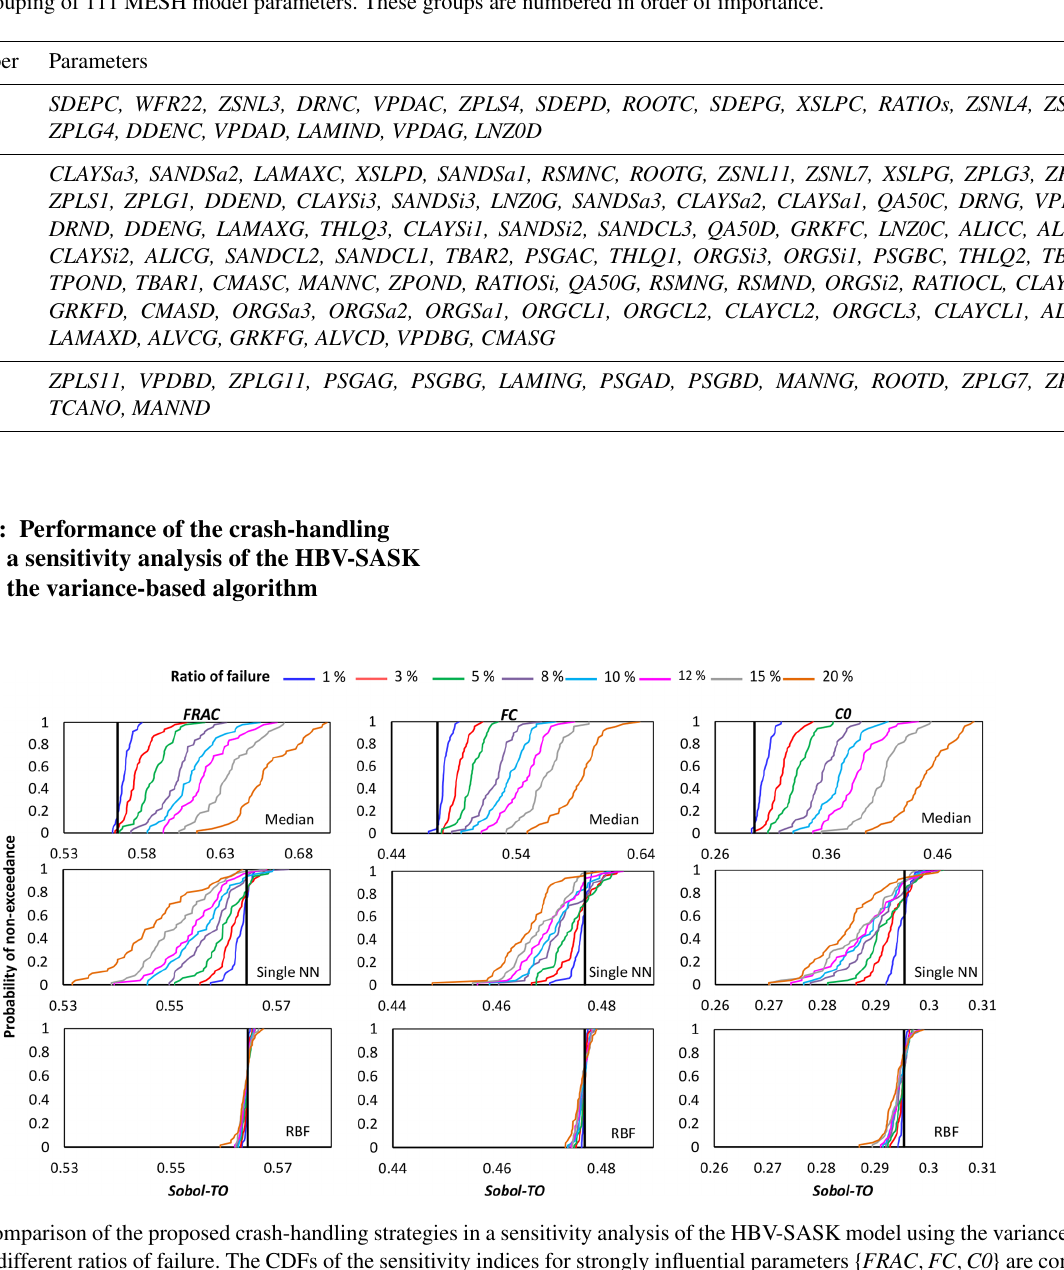
Table A1. Grouping of 111 MESH model parameters. These groups are numbered in order of importance.